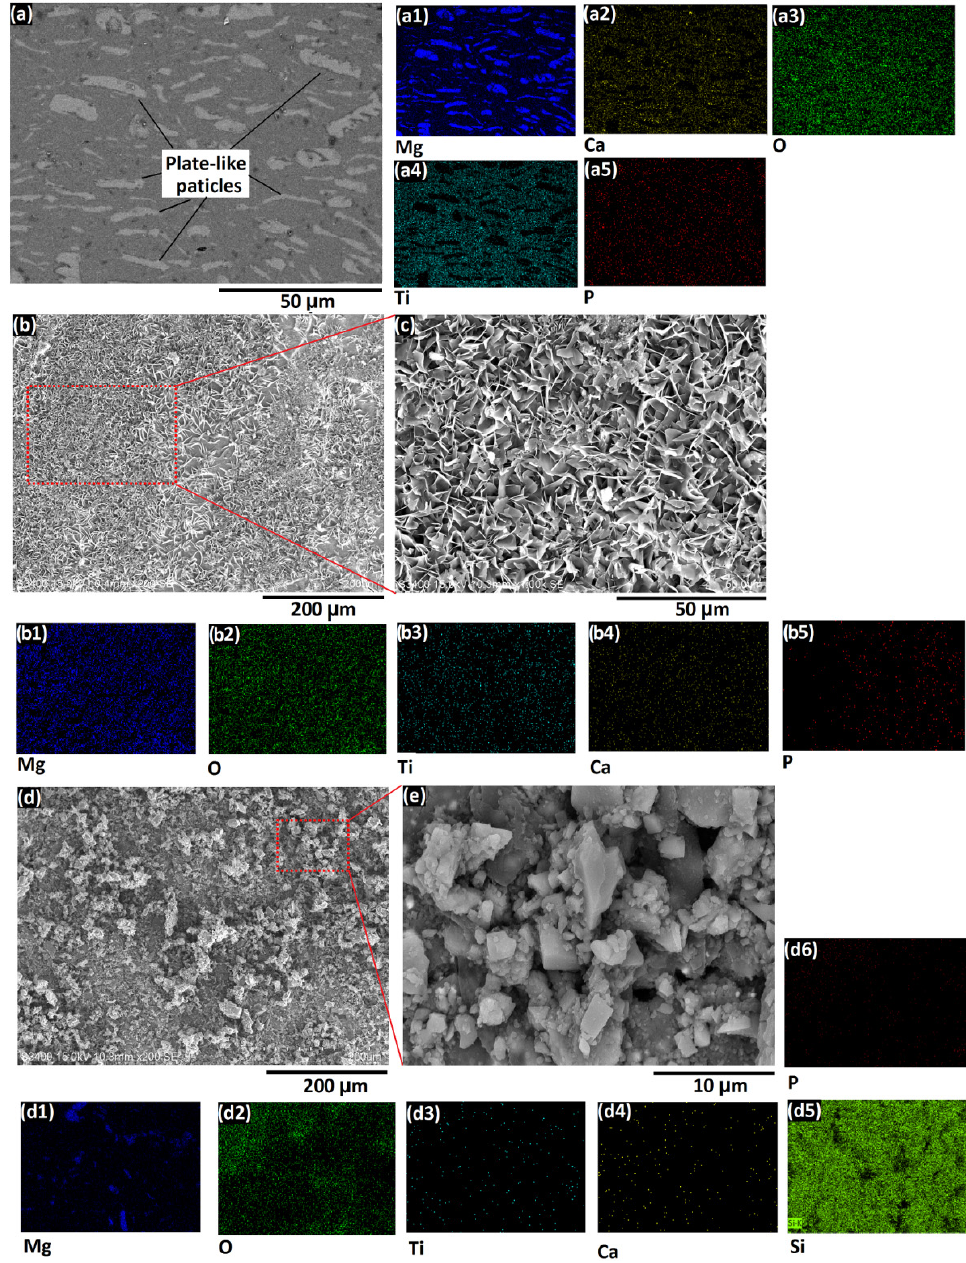
Figure 4. Surface field ‐ emission scanning electron microscopy (FE ‐ SEM) micrographs of ( a ) uncoated; ( b , c ) MgO ‐ coated and ( d , e ) Si/MgO ‐ coated. X ‐ ray elemental mapping of surfaces of ( a1 – a5 ) uncoated,